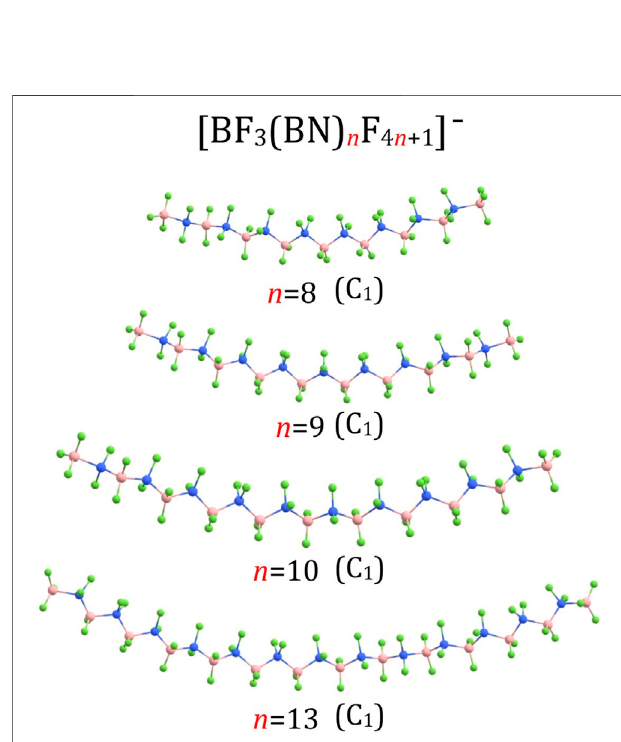
FIGURE 4 | Equilibrium structures of (BF 3 (BN) n F 4 n +1 ) – ( n = 8 – 10,13) anions (symmetry point group in parenthesis).